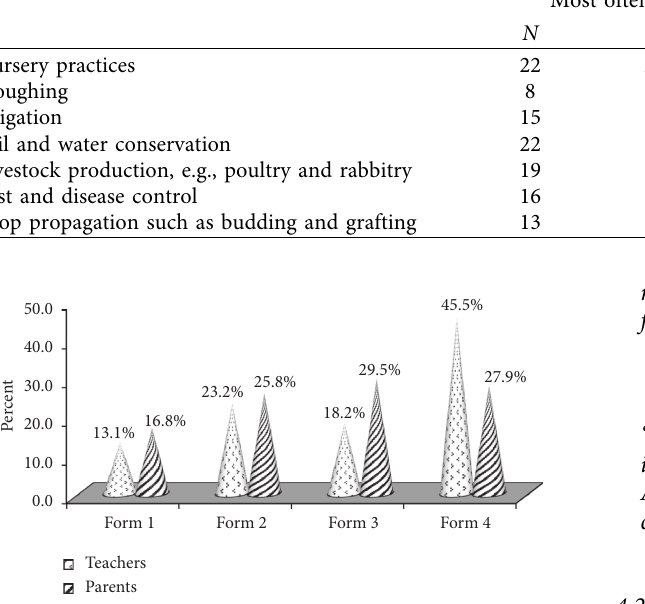
Figure 4: Level at which the students were very active in use of the agricultural skills developed.